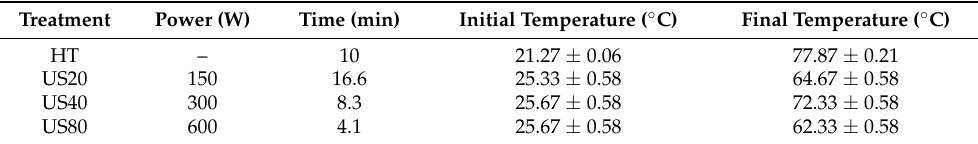
Table 1. HT and HIUS treatment